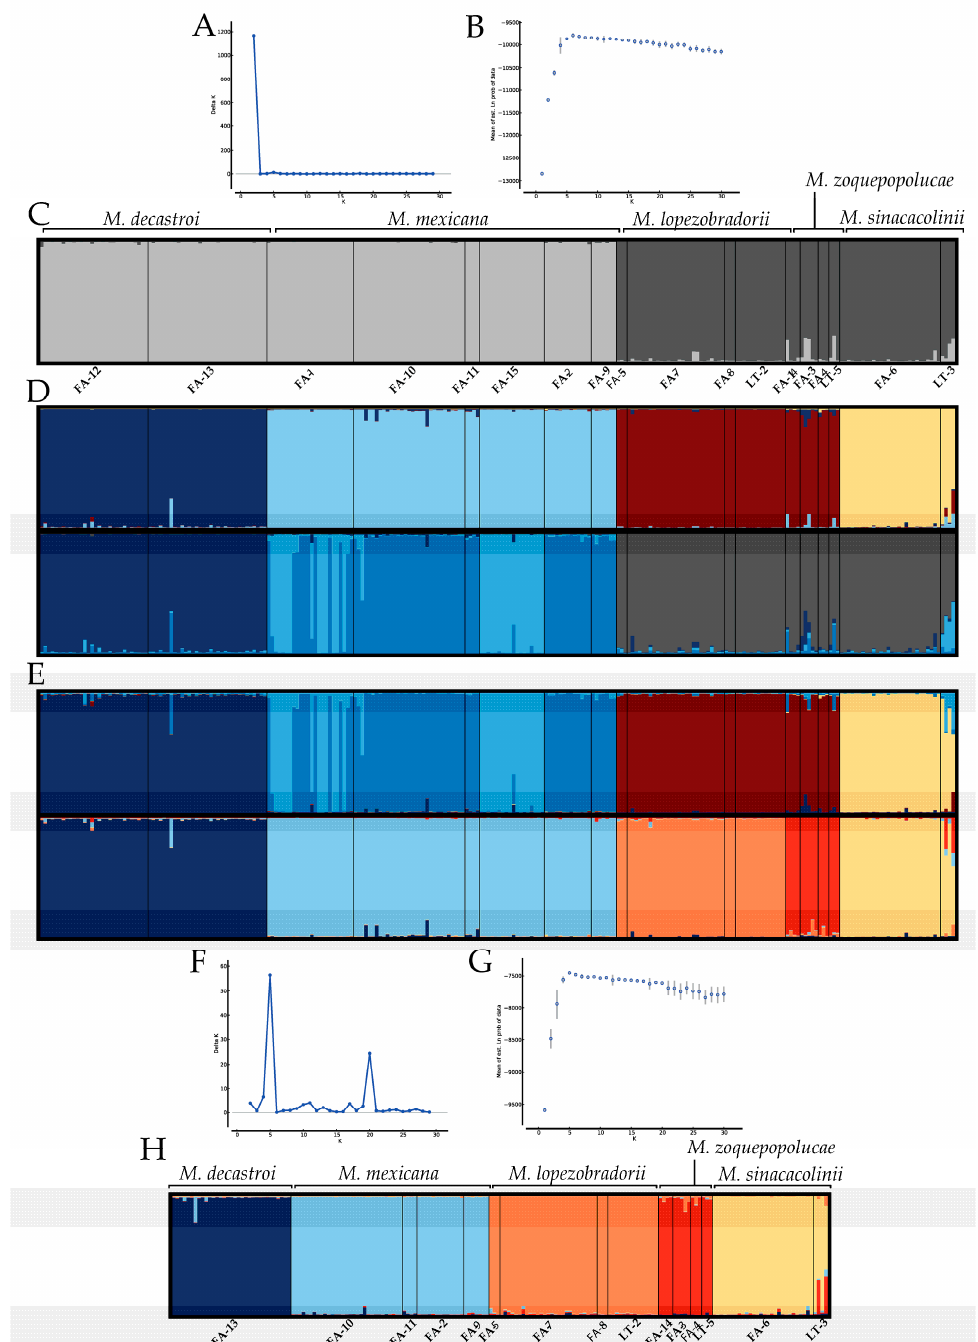
Figure 3. Structure bar plots of Magnolia sect. Talauma individuals in Puebla and Veracruz, Mexico. A–E: analyses on the complete dataset of 18 localities. F–H: analyses of the 15 wild localities only. ( A ) The delta K plot for the complete dataset. ( B ) The mean Ln(K) plot for the complete dataset. ( C ) Representative bar plot (out of ten replicates) for K = 2. ( D ) Representative bar plots for K = 4. The upper bar plot is found in 9/10 replicates, the lower bar plot in 1/10 replicates. ( E ) Representative bar plots for K = 5. The upper bar plot is found in 8/10 replicates, the lower bar plot in 2/10 replicates. ( F ) The delta K plot for the wild localities only. ( G ) The mean Ln(K) plot for the wild localities only. ( H ) Representative bar plot (out of ten replicates) for K = 5.